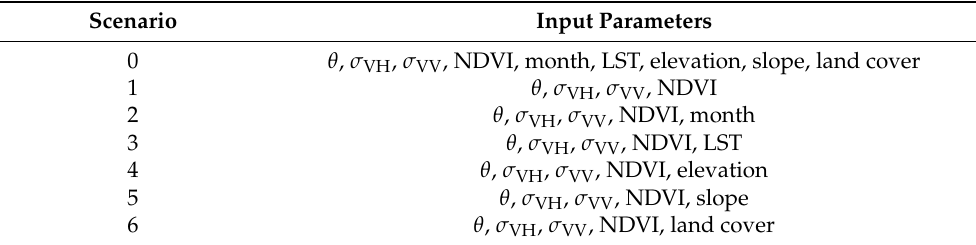
Table 4. Scenarios of input parameter combinations for ANN SMC